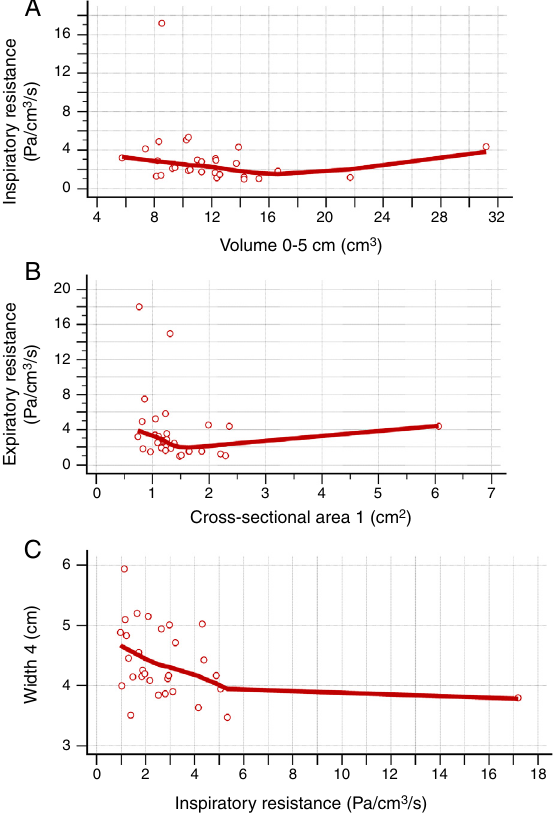
Figure 3 Negative correlation between the data obtained in the acoustic rhinometry, computed rhinomanometry and cone- beam computed tomography. A, Correlation between average inspiratory resistance of computed rhinomanometry and nasal volume of 0---5 cm of acoustic rhinometry (Rho = − 0.382; − 0.653 to − 0.026). B, correlation between average expira- tory resistance of computed rhinomanometry and minimum cross-sectional area 1 of acoustic rhinometry (Rho = − 0.362; 95% CI = − 0.639 to − 0.001). C, Correlation between Width 4 of cone- beam computed tomography and average inspiratory resistance of computed rhinomanometry (Rho = − 0.385; 95% CI = − 0.654 to − 0.029). Statistical analysis was performed by Spearman’s correlation